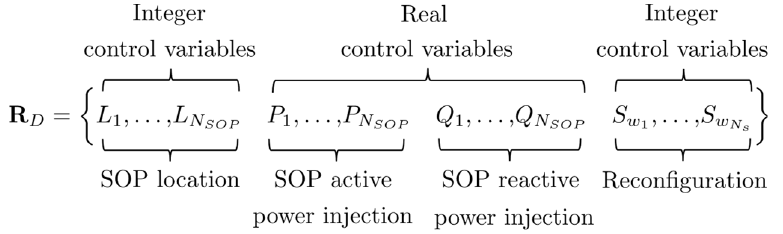
Figure 4. The structure of the initial individual HWCA.